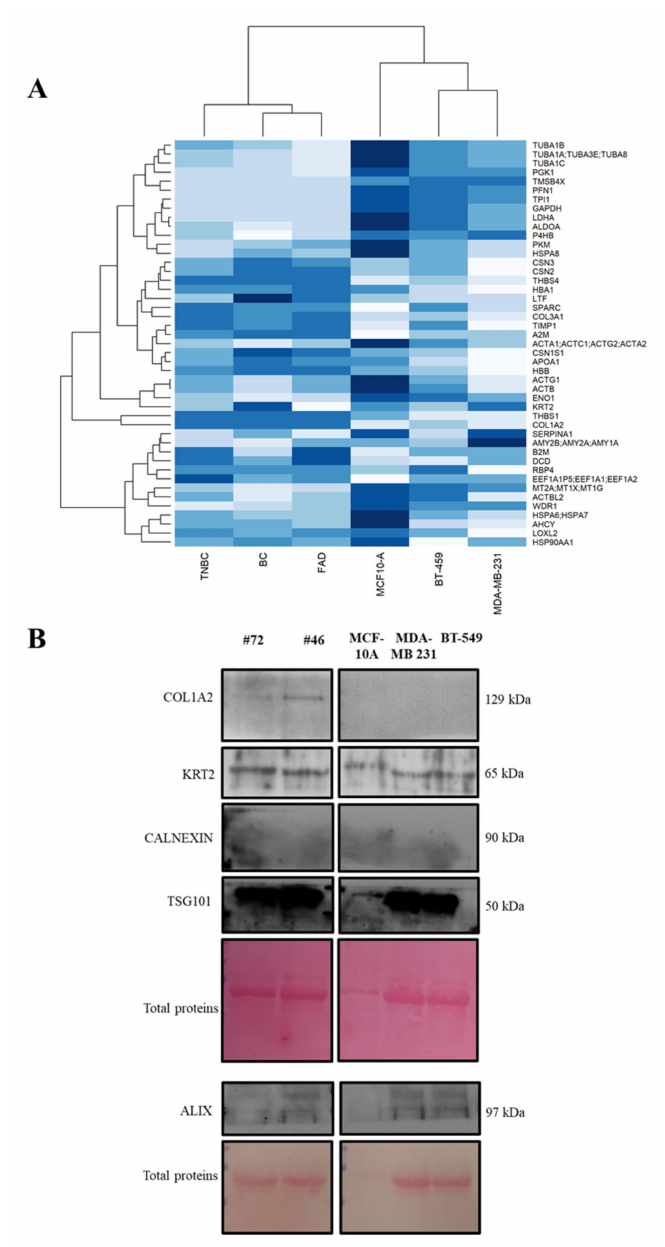
Figure 4. Common protein abundance patterns in EVs from primary BC cells and models. ( A ) Heatmap of non-zero protein mean abundance (log-transformed average values, in the rows) across breast tissue/cell samples (columns, from left to right side), respectively. Color intensity from low abundance (white) to high abundance (blue). BC, breast cancer; TNBC, triple–negative; FDA, fibroadenoma. ( B ) Western blot analysis of COL1A2, KRT2, CALNEXIN, TSG101, and ALIX in EVs from FAD patient #72, HER2+ BC patient #46, and the three IBCC lines. The heatmap shows the abundance patterns for non-zero mean abundance proteins (rows) across the different samples (columns). We found different patterns of abundance for most EV proteins in primary cells vs. IBCCs. Proteins with the most similar pattern across the two were collagen type I alpha 2 chain (COL1A2) and keratin type II (KRT2), an intermediate filament protein member. The ranked relative abundance (log LFQ intensity) of the identified protein groups is shown in Figure